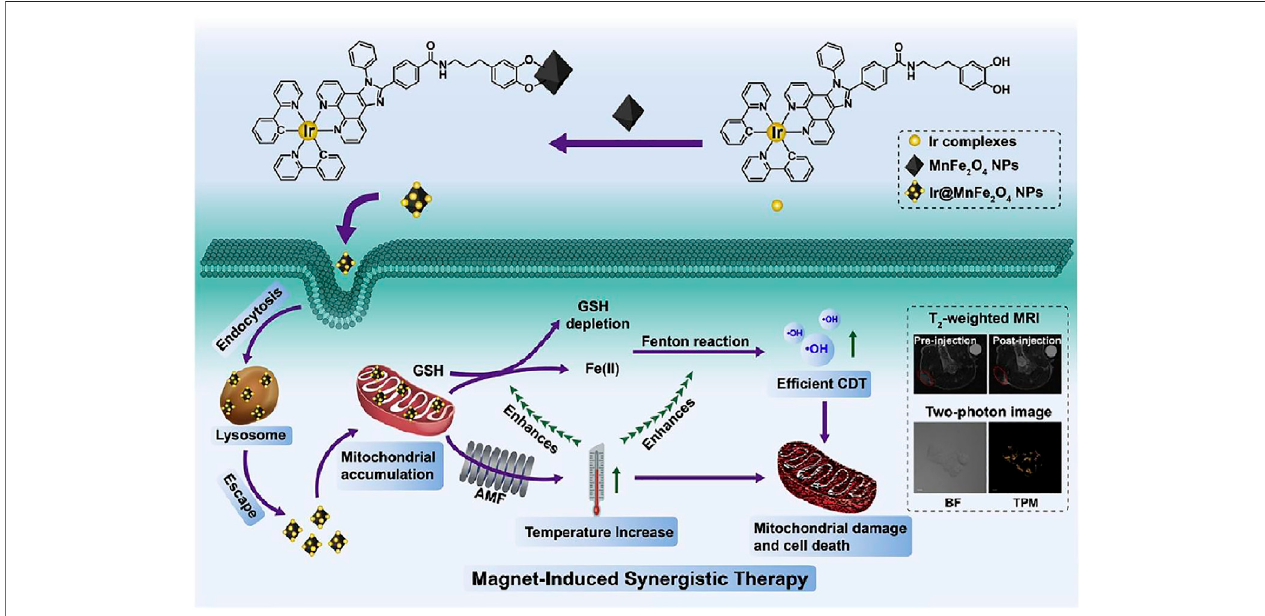
FIGURE4| ThesynthesisofIr@MnFe2O4NPs,andaschematicrepresentationofIr@MnFe2O4NPsasmitochondria-targetingmagnetothermogenic nanozymes for magnet-induced synergistic therapy. Reproduced with permission from Shen J. et al. (2020). Copyright (2020) Elsevier.